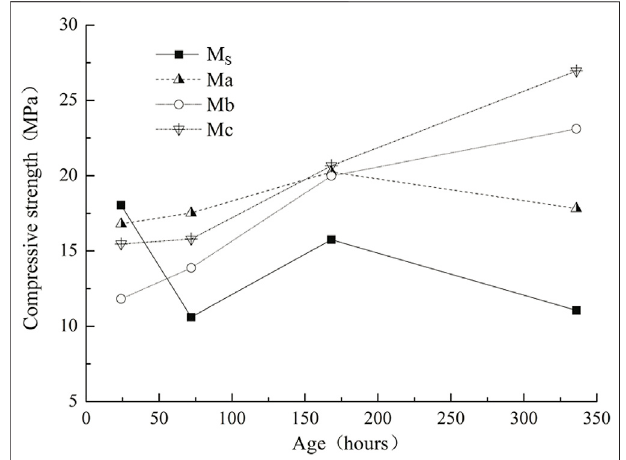
FIGURE2| In fl uenceofadmixtureonearlystrengthofaluminatecement stone (50 °